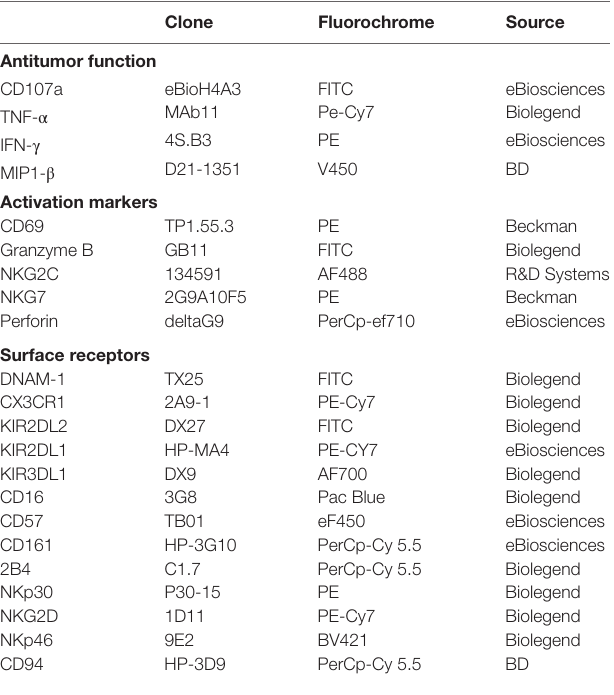
Table 2 | Natural killer cell surface or intracellular parameters analyzed.